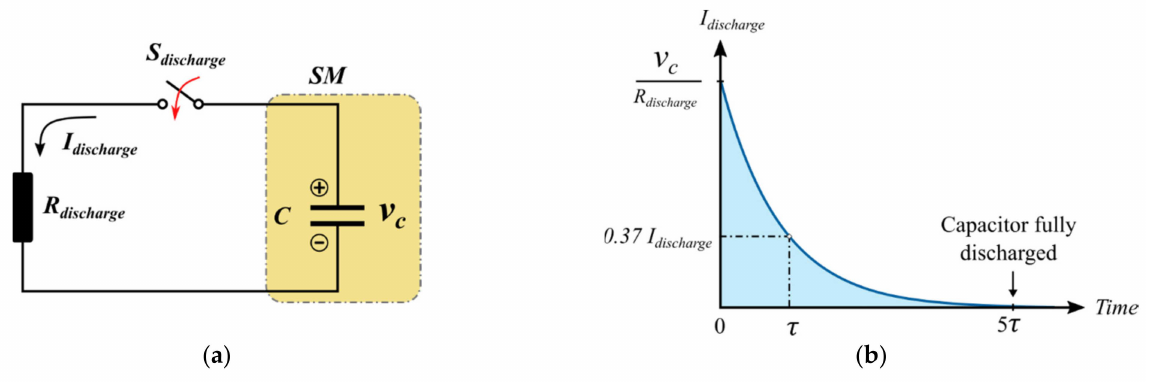
Figure 9. ( a ) Discharging system for single SM; ( b ) Capacitor discharging